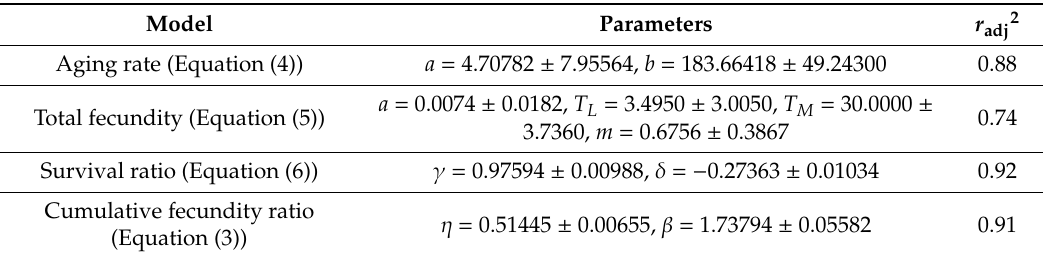
Figure 3. The age-specific survival rate ( l x ), the age-specific fecundity ( m x ), and the age-specific maternity ( l x m x ) of A. solani in response to different temperature conditions. Table 5. Several models and their parameters for A. solani adults in Figure